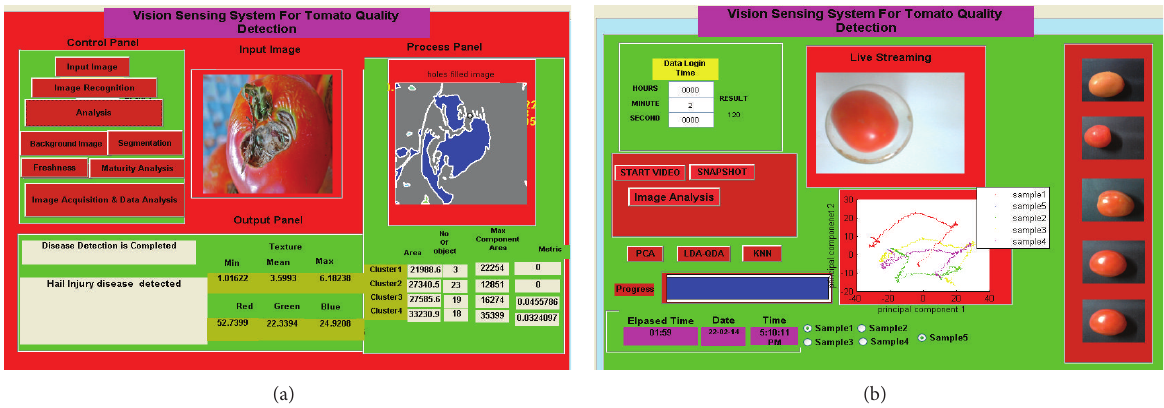
Figure 7: (a) Developed GUI prediction of freshness, maturity level, and disease detection and classification and (b) developed GUI for image acquisition and disease attack prediction.